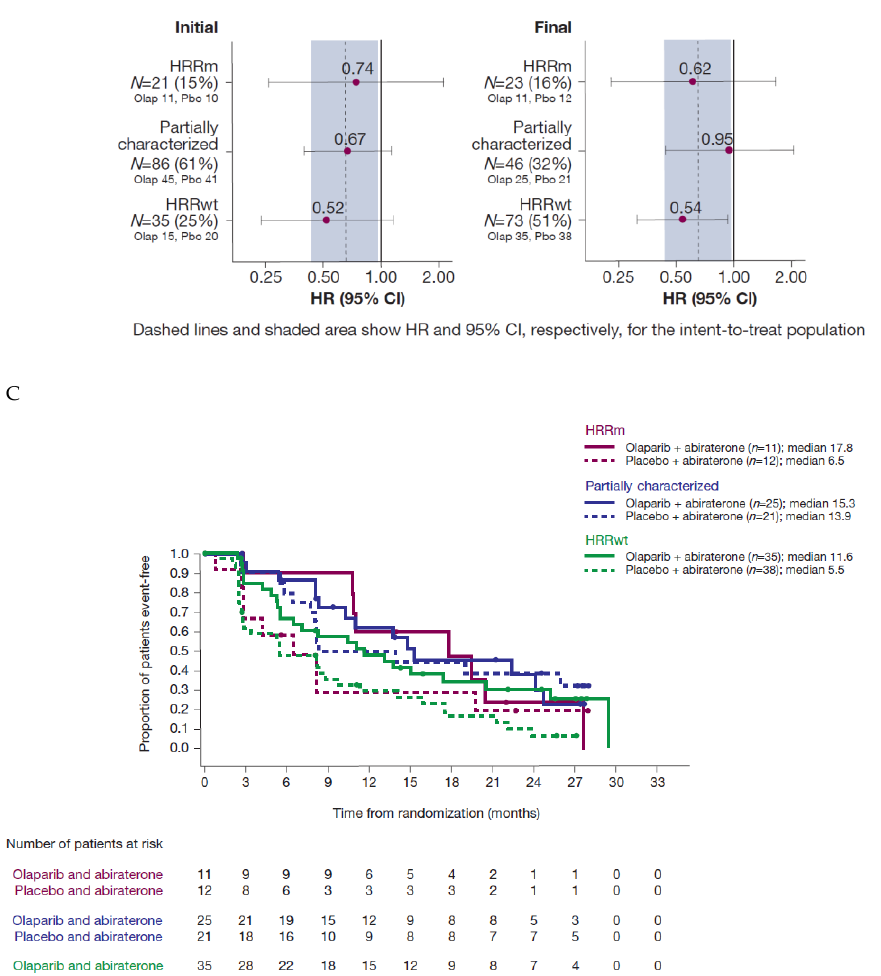
Figure 4. Forest plots by HRRm subgroup as defined in the ( A ) initial and ( B ) final datasets; dashed lines and shaded area show HR and 95% CI of the primary rPFS analysis, respectively, for the ITT population. Kaplan–Meier curves for the ( C ) HRRm, partially characterized and HRRwt subgroups in the final dataset. (CI, confidence interval; ctDNA, circulating tumour DNA; HR, hazard ratio; HRR, homologous recombination repair; HRRm, HRR mutation; HRRwt, HRR wild type; ITT, intent- to-treat; olap, olaparib; pbo, placebo; rPFS, radiographic progression-free survival; VAF, variant allele